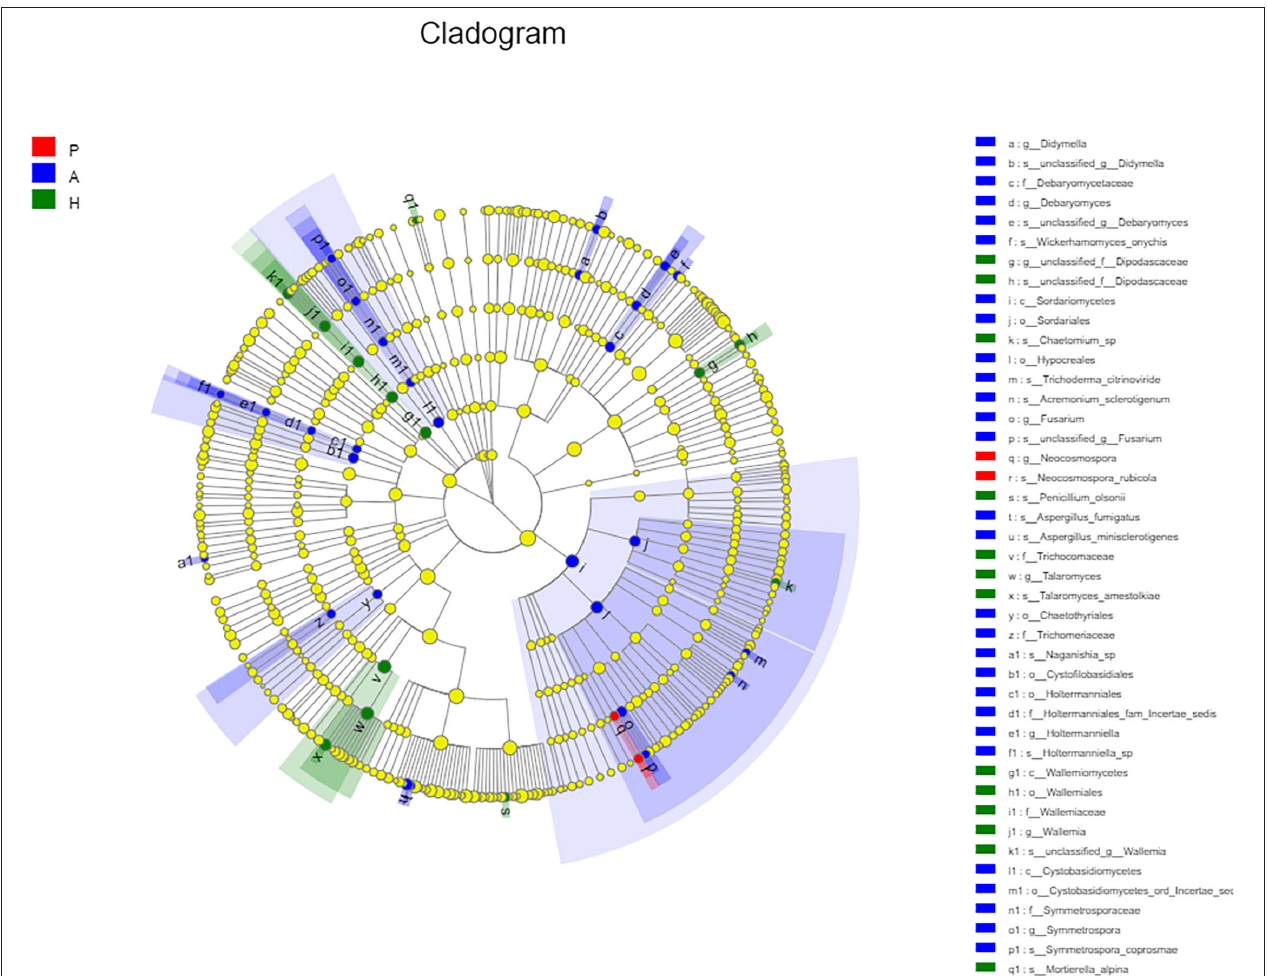
FIGURE 14 | Cladogram of fungal flora. Nodes with different colors indicate microbial groups that were enriched and show significant differences among the groups. Yellow nodes indicate microbial groups without significant differences among the groups. The size of the circle in the cladogram was proportional to fungal abundance. Moving from the inside to the outside, the circles represent the phylum, class, order, family, and genus of fungi,